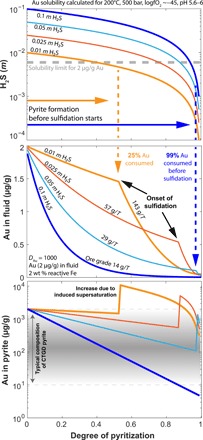
Modeled evolution of H2S and Au in hydrothermal fluids and pyrite for CTGD systems.Reaction of hydrothermal fluids with reactive Fe at concentrations common in CTGD leading to Au-rich pyrite. Numerical model assumes complete consumption of H2S from the fluid to form pyrite. Au concentration depends either on partitioning (at low degrees of pyritization) or supersaturation due to sulfidation (at high degrees of pyritization). The gold solubility limit will decrease during pyritization as Au is consumed because of partitioning. The onset of sulfidation causes a marked increase in modeled Au concentration in pyrite. Under these conditions, typical compositions of CTGD pyrite are only formed at the very end of pyritization (gray field). When partitioning is the major ore-forming process, typical CTGD compositions are produced during the course of pyritization. Ore grades are calculated from amounts of fluid and rock and initial Au concentration (see the Supplementary Materials).